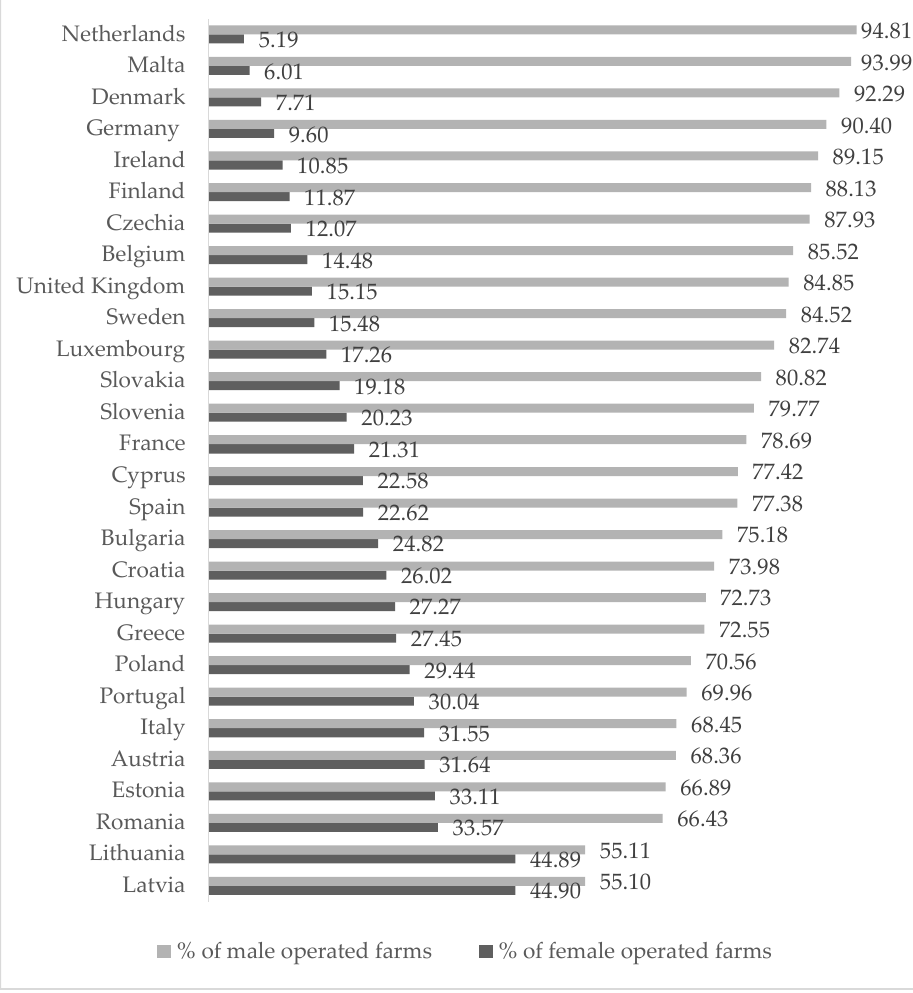
Figure 1. Female- vs. male-operated farms (% on the total). Source: own calculations based on Eurostat and Word Bank data.